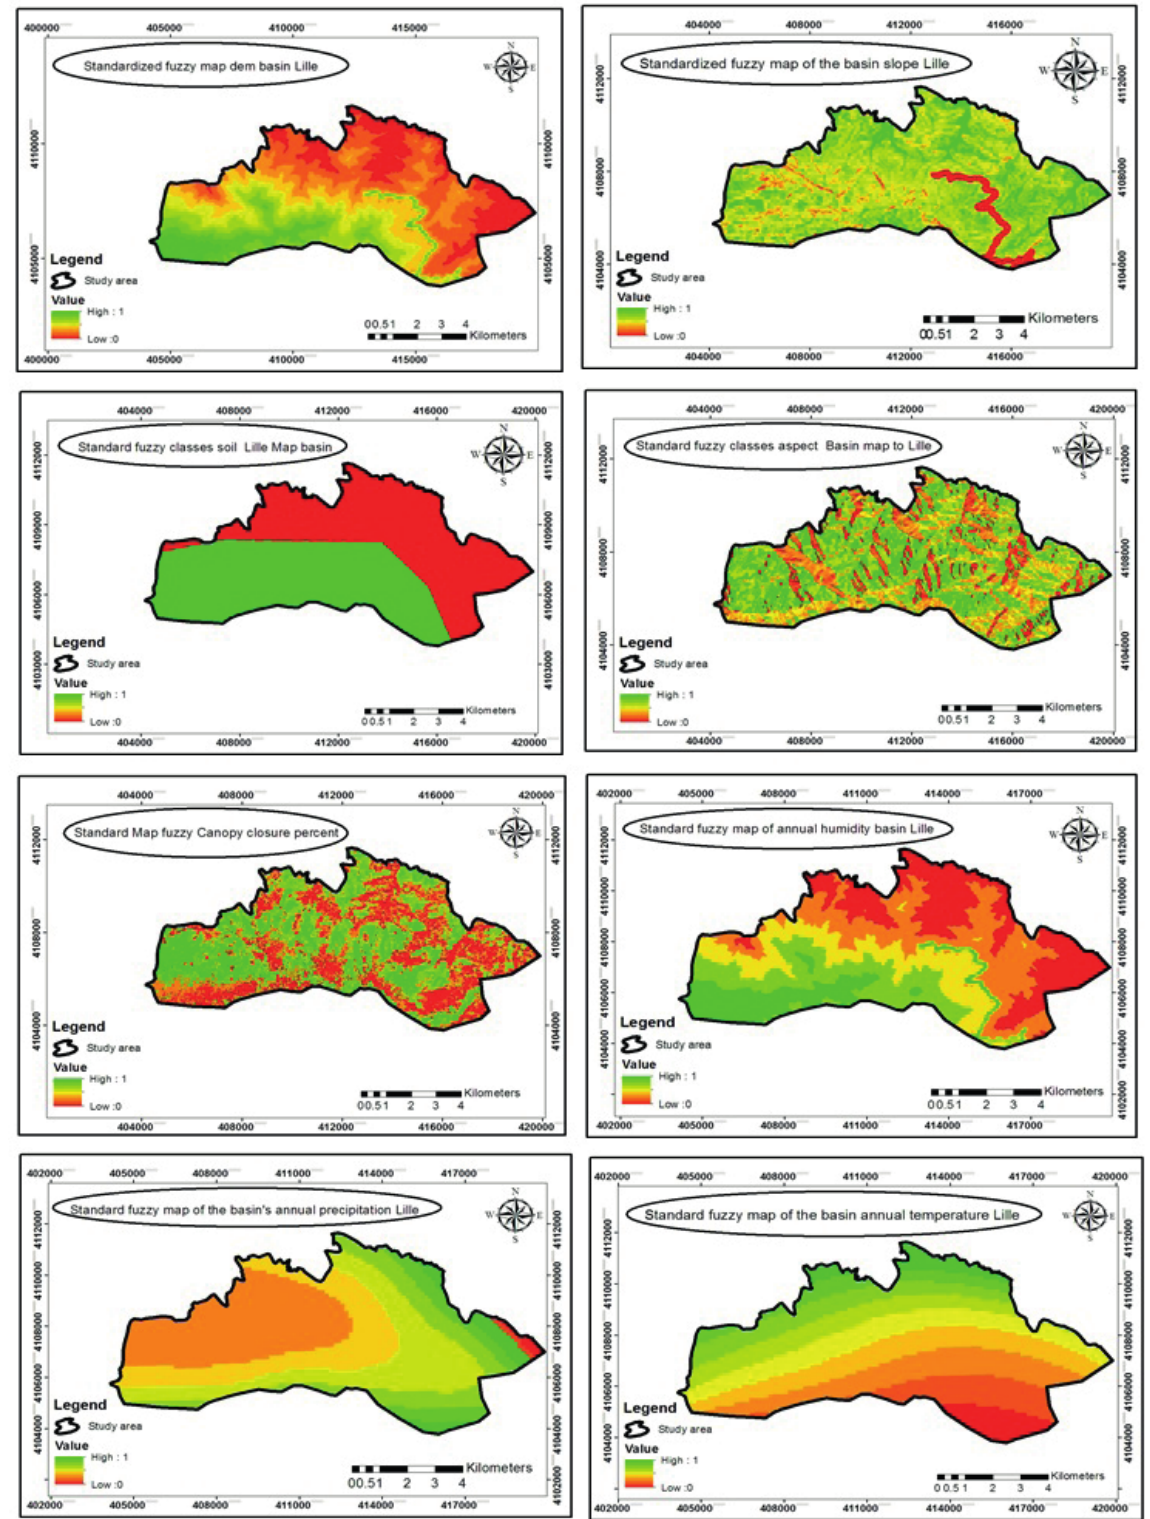
Figure 2 - Standardized fuzzy